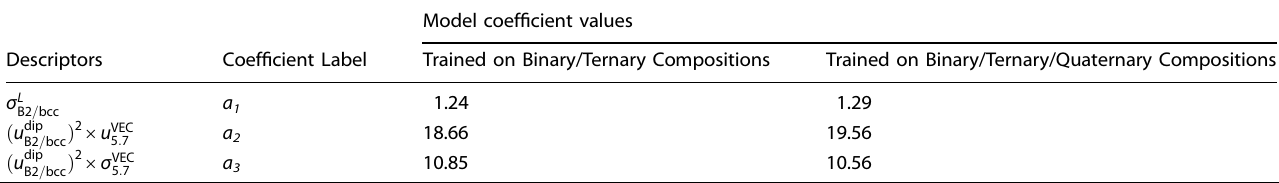
Table 1. Comparison of values of the fi tting coef fi cients when the RMSAD surrogate model (Eq. 1) is trained with two different datasets. Model coef fi cient values